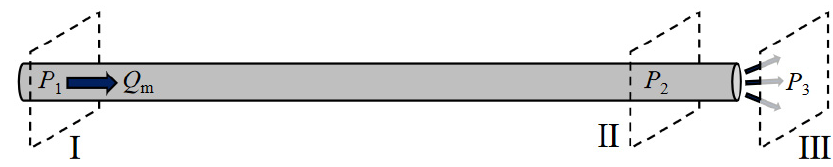
Figure 6. Schematic illustration of gas flow within broken pipe.